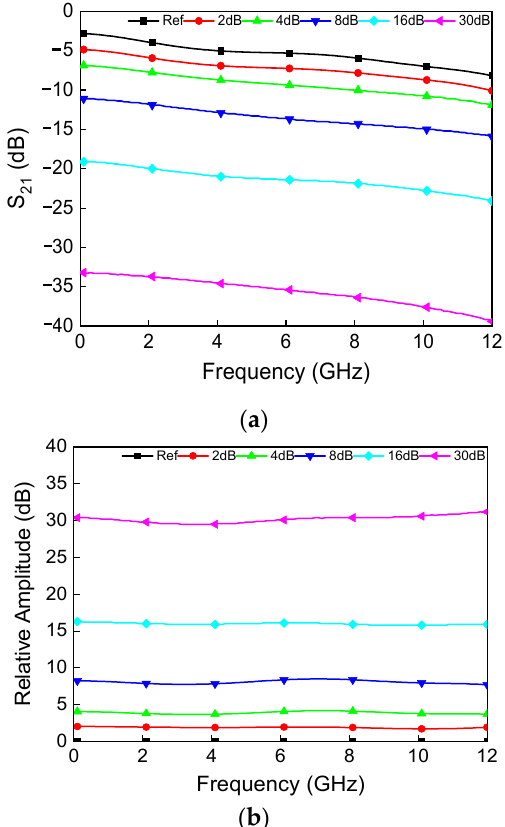
Figure 6. Measured ( a ) S 21 , and ( b ) normalized attenuation of the GaN digital step attenuator MMIC.